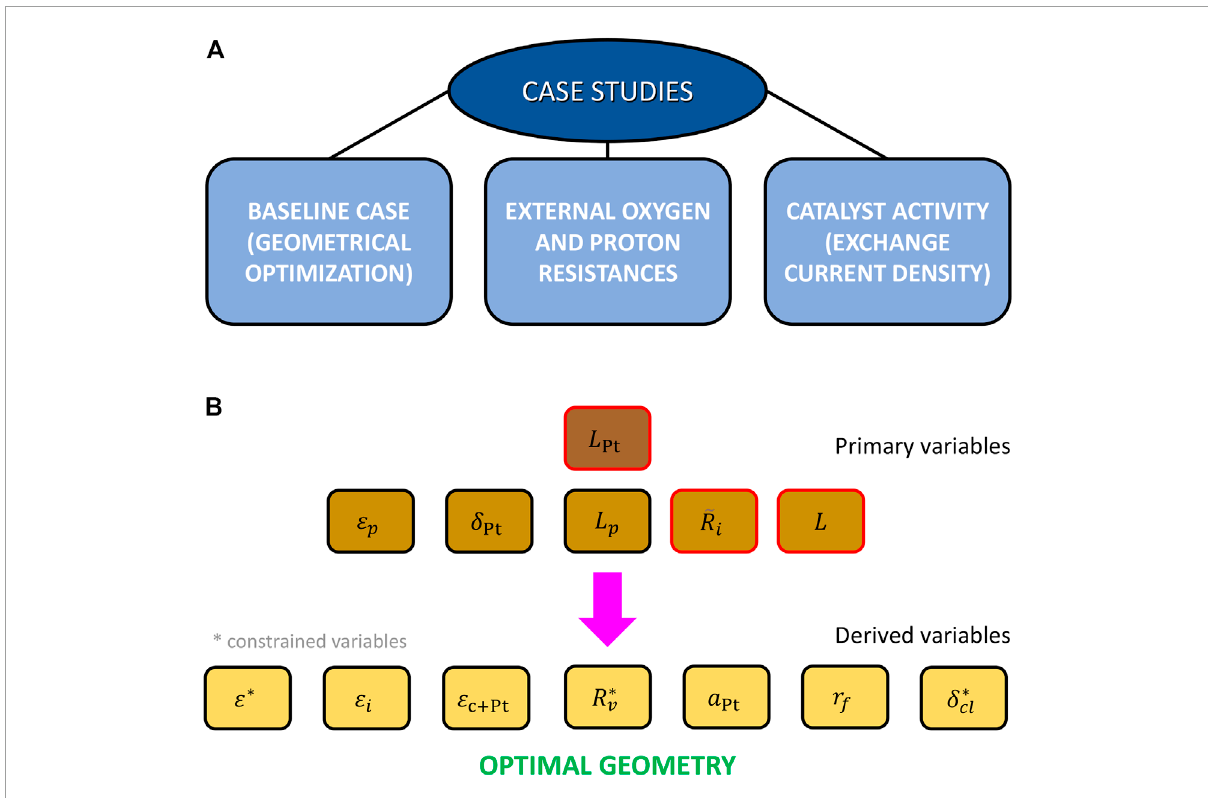
FIGURE 6 (A) Diagram of the case studies examined. The analysis of the baseline case with the geometrical optimization of the bi-functionalized cathode CL microstructure is presented in Section 6.1 , the effect of the external oxygen and proton transport resistances, R chcl O in Section 6.2 , and the effect of the catalyst activity, i o , c , is presented in Section 6.3 . (B) Flow chart of the optimization process to determine the optimal bi-functionalized cathode CL. Fixed and derived variables are indicated by boxes with black border and variables that were examined parametrically are indicated by boxes with red border. Constrained variables are marked with an